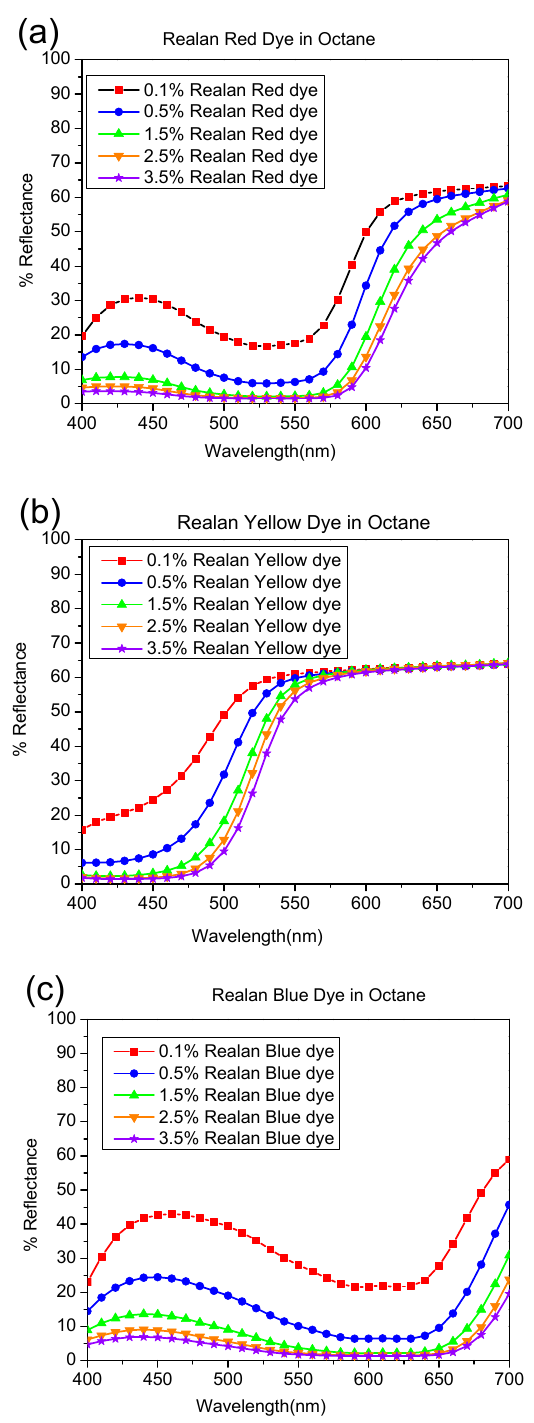
Figure 4. Percentage of reflectance value vs. wavelength (nm) of wool fibers dyed by ( a ) Realan Reactive Red, ( b ) Realan Reactive Blue, and ( c ) Realan Reactive Yellow in octane.